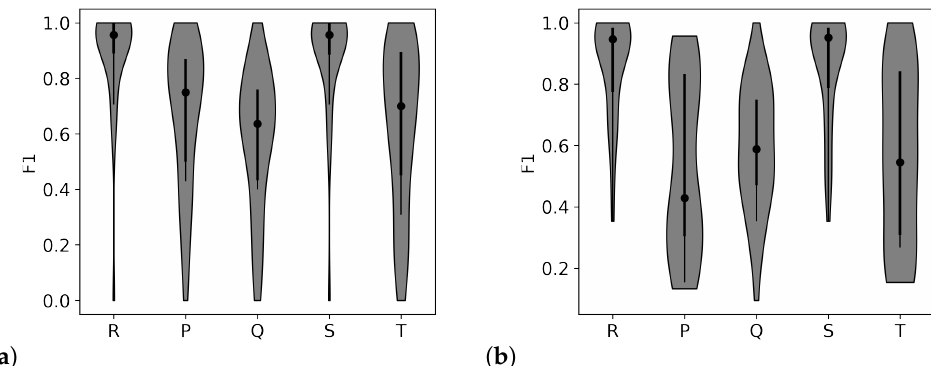
Figure 5. Each plot again shows the F1 metric for each thread subset of electrodes. The left plot ( a ) shows the data from all electrodes with silver thread across all participants, and the right plot ( b ) shows the data from all electrodes with steel thread across all participants. Both sets performed similarly for the R and S peaks; however, the silver electrodes performed better (with higher median values and tighter distributions) in detection of the P, Q, and T